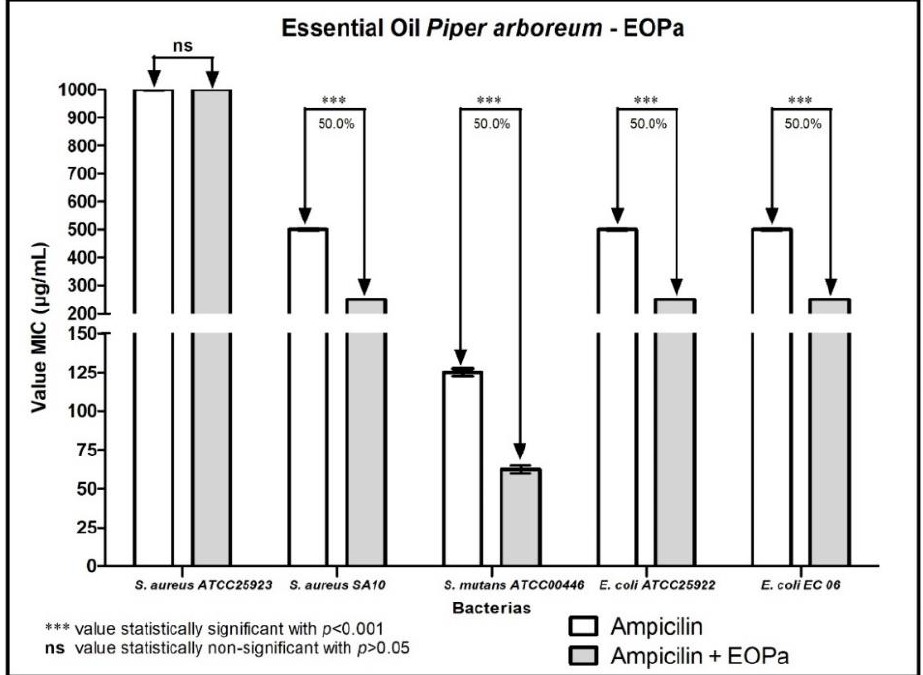
Figure 3. Evaluation of the modulatory activity of EOPa combined with ampicillin against bacterial strains.